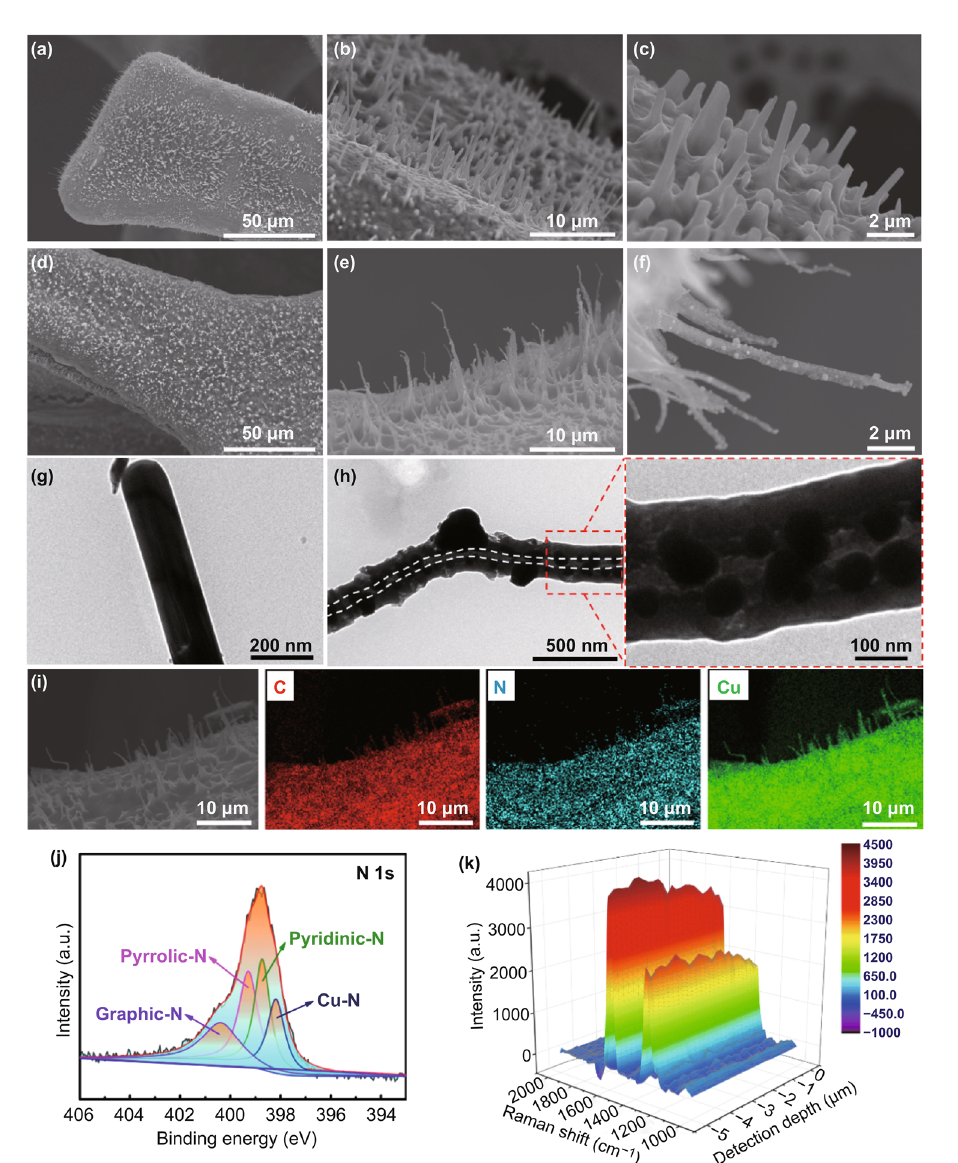
Fig. 2 SEM images of a‑c oxidized CF and d‑f CLCS. TEM images of g oxidized CF and h CLCS. i EDS mapping containing C, N and Cu ele- ment for CLCS. j XPS survey spectra (N 1s) and k Raman spectra at different depths of